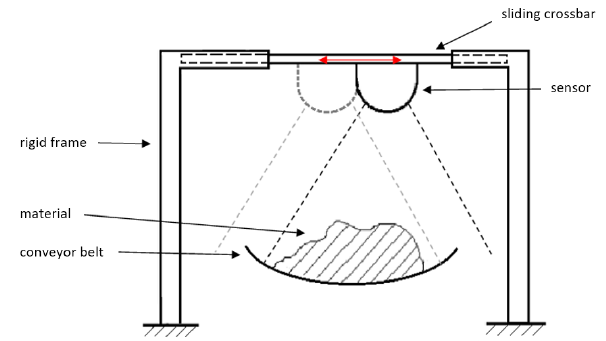
Figure 7: Sliding crossbar